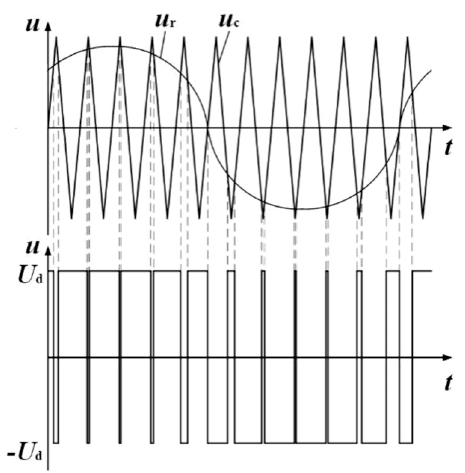
Figure 9. The control circuit of PWM inverter-circuit power supply.